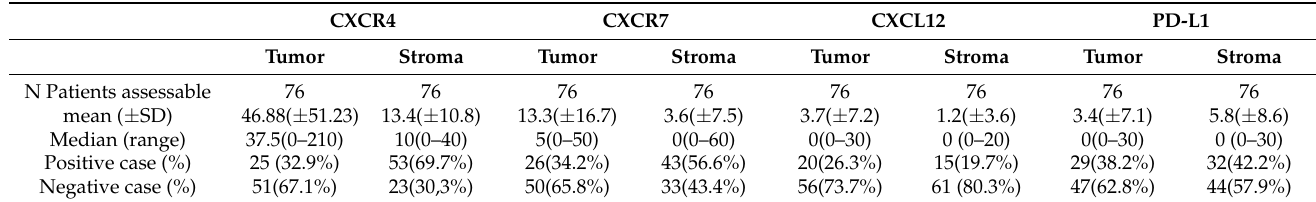
Table 2. CXCR4, CXCR7, CXCL12 and PD-L1 expression in